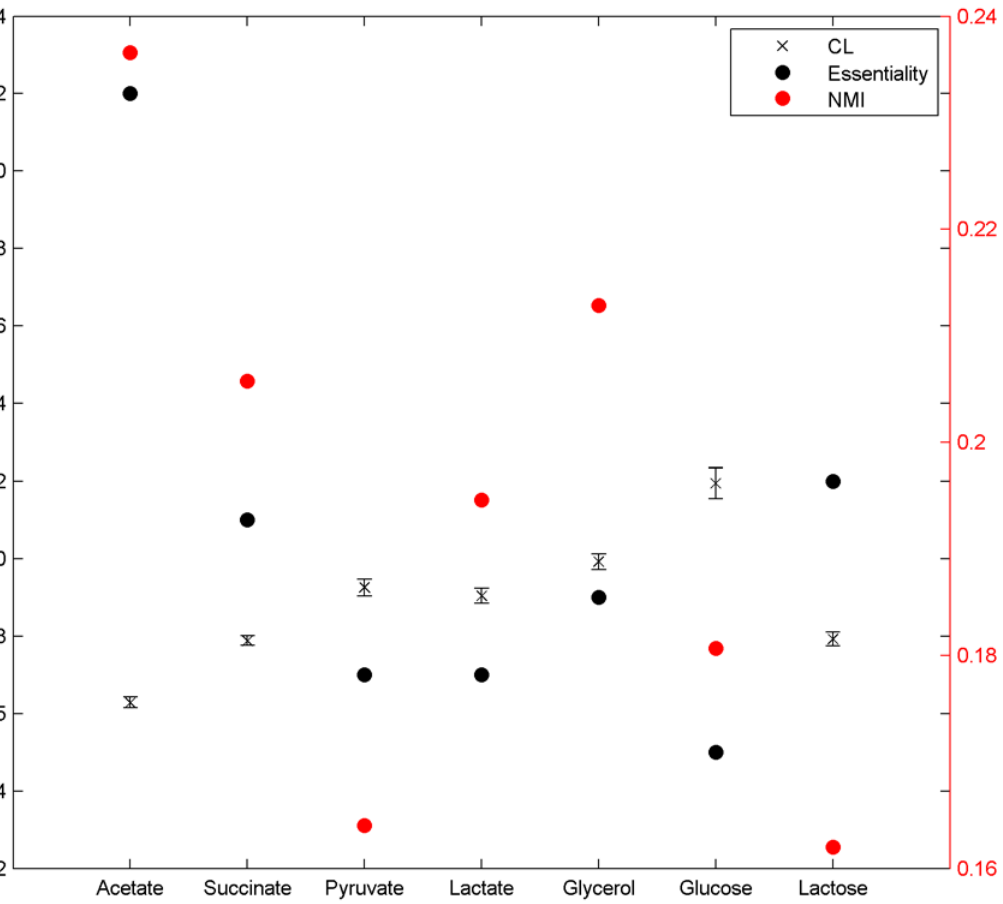
Figure 3. Summary statistics on the structure of E.coli’s metabolic network GPM. Shown are the correlation length (CL) of phenotype differences, the normalized mutual information (NMI) of genotype differences relative to phenotype differences, and the number of essential genes (essentiality) found in the metabolic network, under different environmental conditions. The environments are listed in increasing order of quality, except in the case of lactose whose position in the rank-ordering is not known precisely. The NMI was computed as described in Materials and Methods, using a mutation rate per genotype position of 0.001. Error bars indicate 95% confidence intervals.